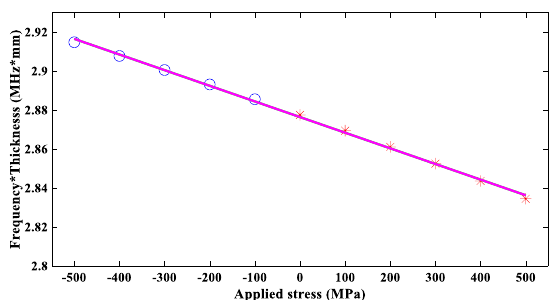
Figure 6 Frequency shift of S1-ZGV Lamb mode under uniform stress (Black circles and red stars denote compressive stress and tensile stress. Red line refers to the fitted